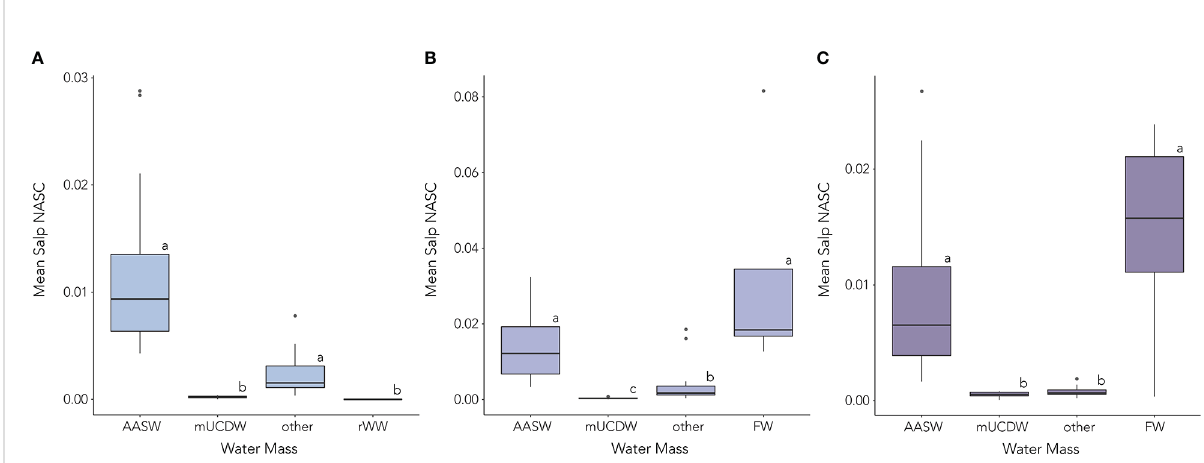
FIGURE 6 Mean integrated salp NASC (calculated from integrated PRC NASC per water mass for each pro fi le) per present water masses during the (A) early, (B) mid, and (C) late season regimes. Water masses included Antarctic Surface Water (AASW), modi fi ed Upper Circumpolar Deep Water (mUCDW), an